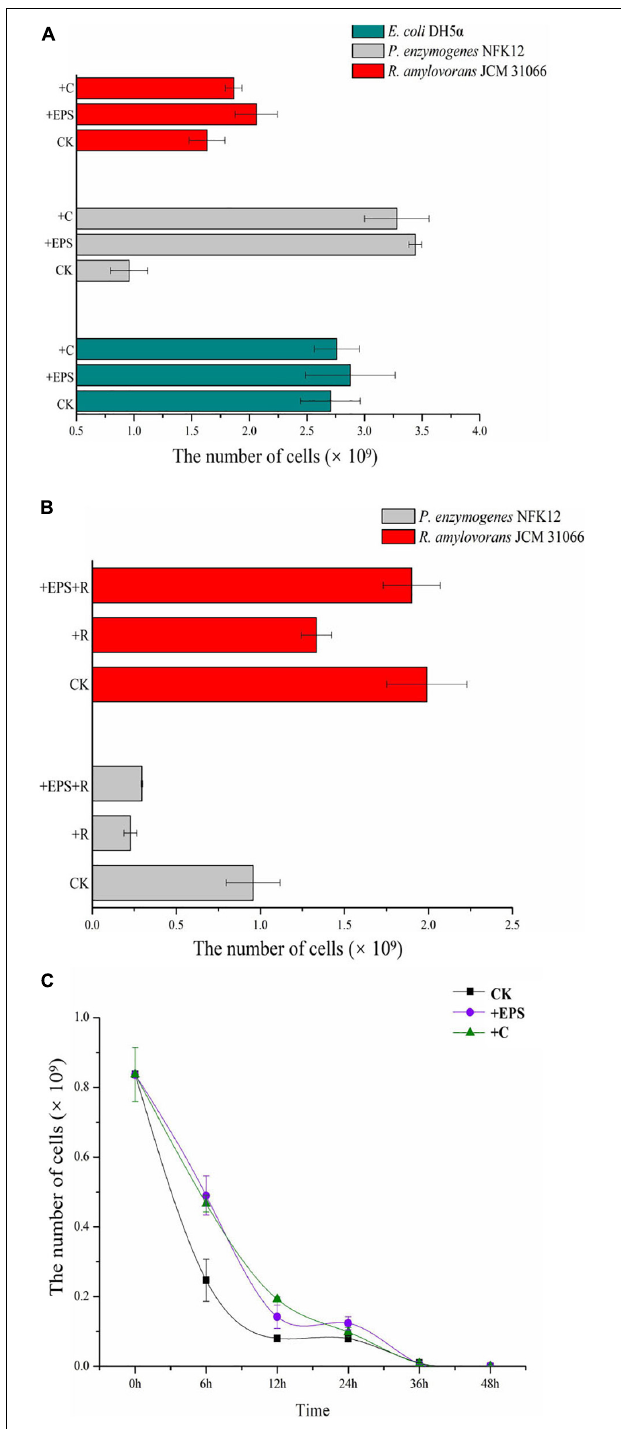
FIGURE 4 | The CFU of the control and experimental groups and the number of CFU cells. (A) Effect of EPS and chitosan on the bacterial growth by comparing biomass of strains supplemented EPS against non-EPS supplementing strains. (B,C) The effect of EPS on the antibiotic tolerance of strain NFK12 T was studied by measuring the biomass of strain NFK12 T . EPS, exopolysaccharides; C, chitosan; R, norfloxacin; CK, control; +,